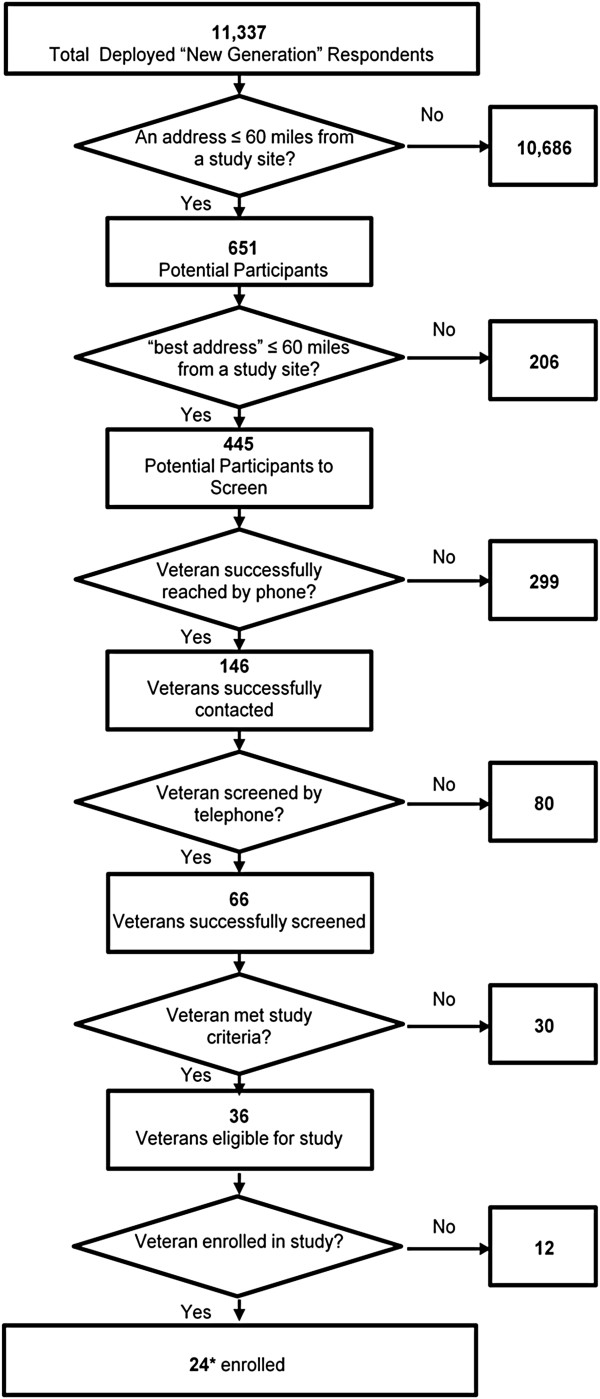
Flowchart of each stage of the screening process. *One participant withdrew consent. Final enrollment n = 23. Note: the 11,337 total deployed “New Generation” sample was derived from a larger sample of 13,162 respondents after removing individuals who did not meet the age criteria (18- 50 years).